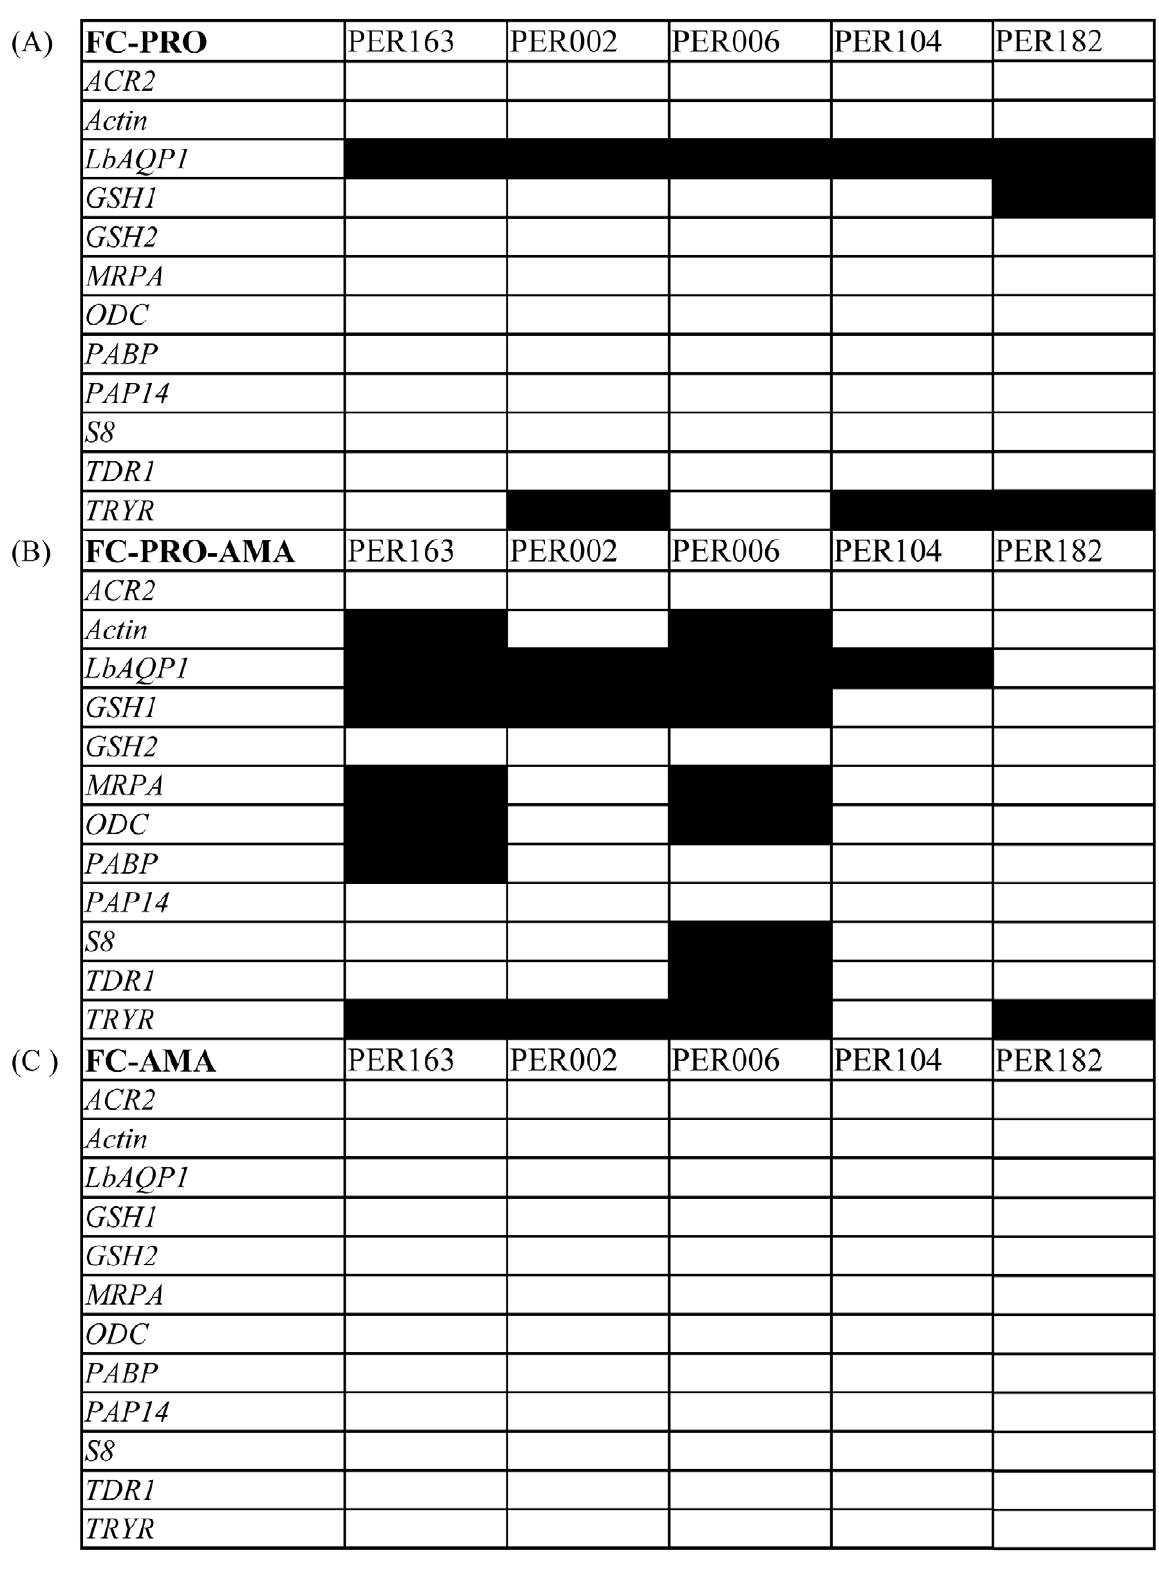
Figure 6. Gene expression modulation in different development stages of studied isolates. Modulation of gene expression can be in the form of increased expression (up-regulation) or decreased expression (down-regulation); a 2-fold cutoff was used here. (A) FC-PRO, measure of gene expression modulation during development of promastigotes (highlighted in black if up-regulation –i.e. at least 2-fold increase– is present). (B) FC- PRO-AMA, measure of gene expression modulation during transition from promastigotes to amastigotes (highlighted in black if modulation, always